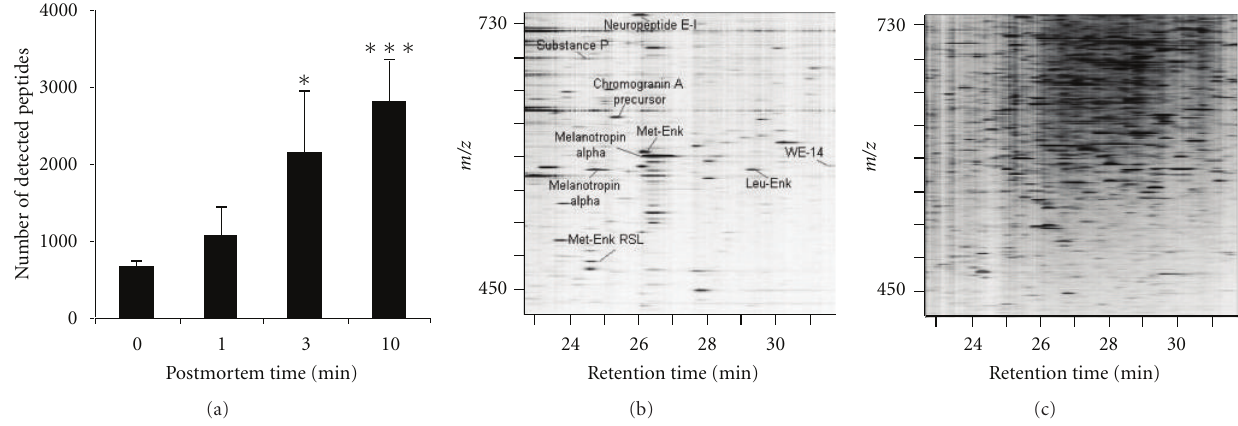
Figure 4: E ff ect on the number of detected (neuro)peptides (from mouse hypothalamus) by postmortem time (time between tissue col- lection and heat denaturation/stabilization) [104]. (a) Number of detected peptides by nano-LC ESI MS rapidly increases with postmortem time. (b, c) Two-dimensional peptide displays of control group and 10 min postmortem group, respectively. Picture adapted from Sk¨old et al.